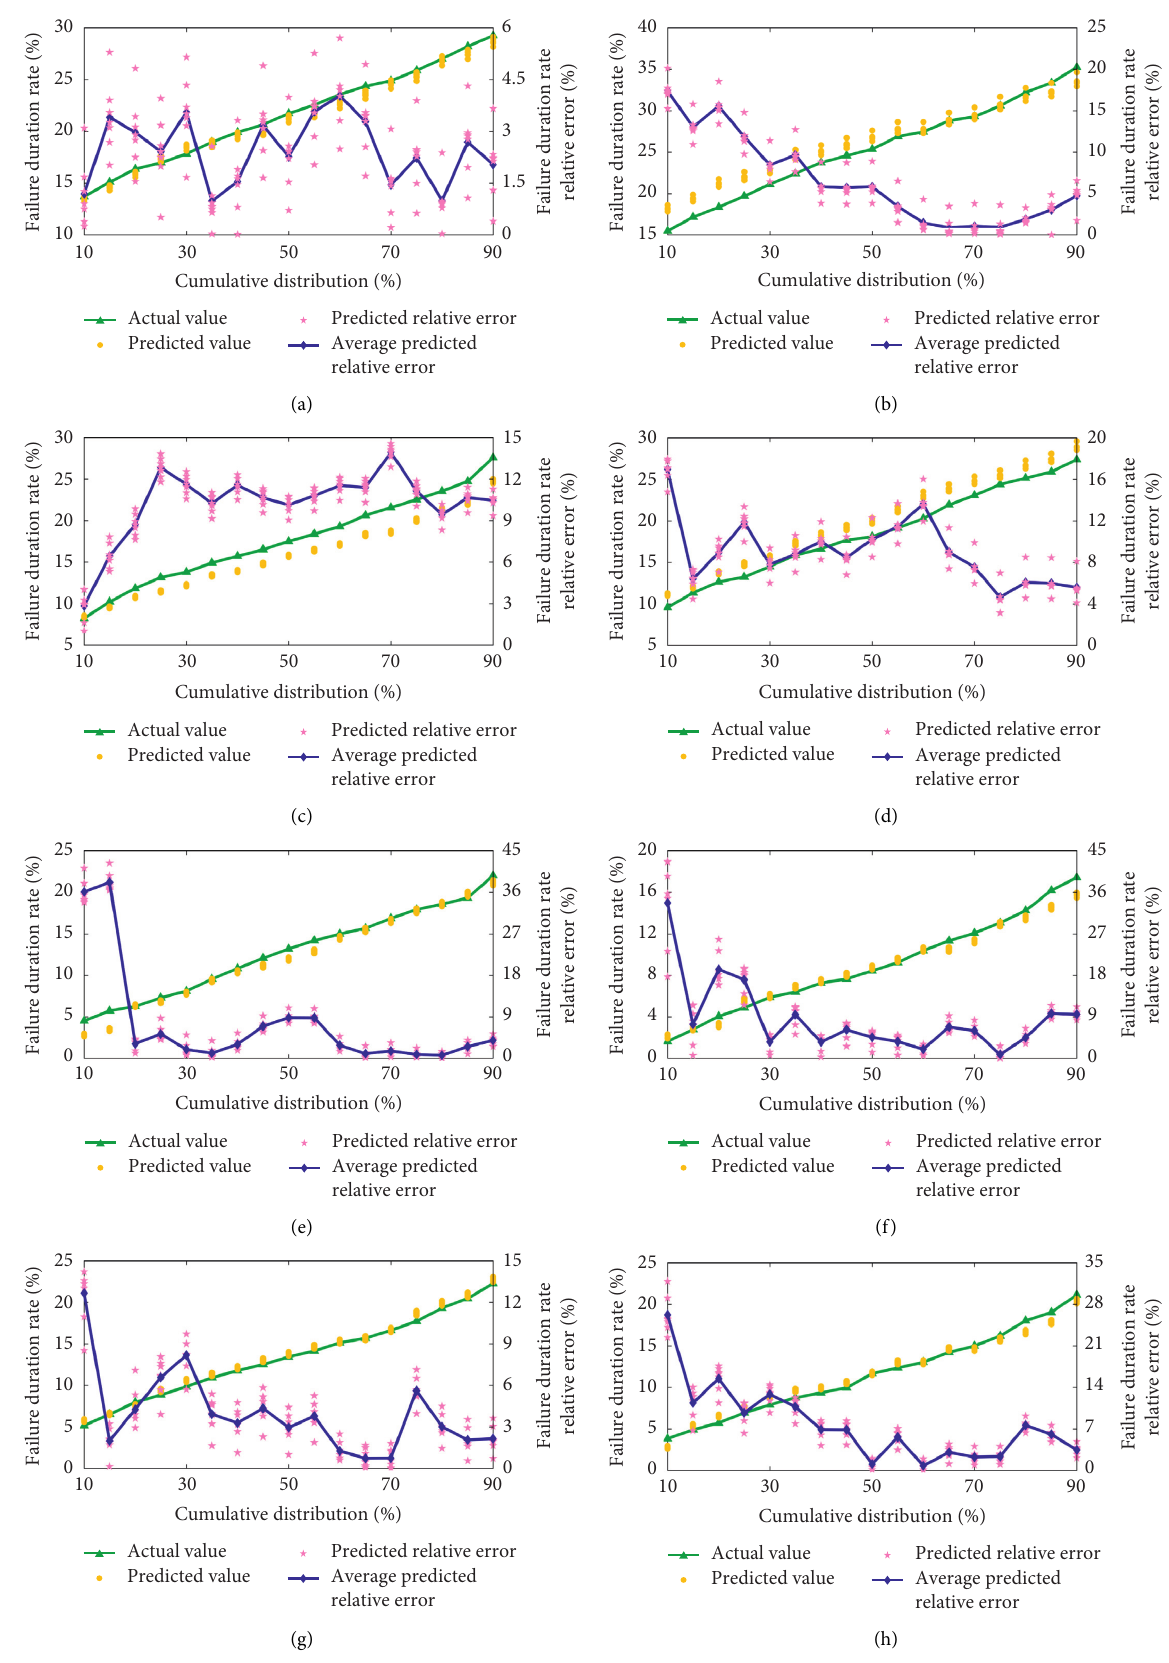
Figure 13: Results of FDR estimation for test bus stops at CDF levels. (a) No.1 bus stop. (b) No.2 bus stop. (c) No.3 bus stop. (d) No.4 bus stop. (e) No.5 bus stop. (f) No.6 bus stop. (g) No.7 bus stop. (h) No. 8 bus